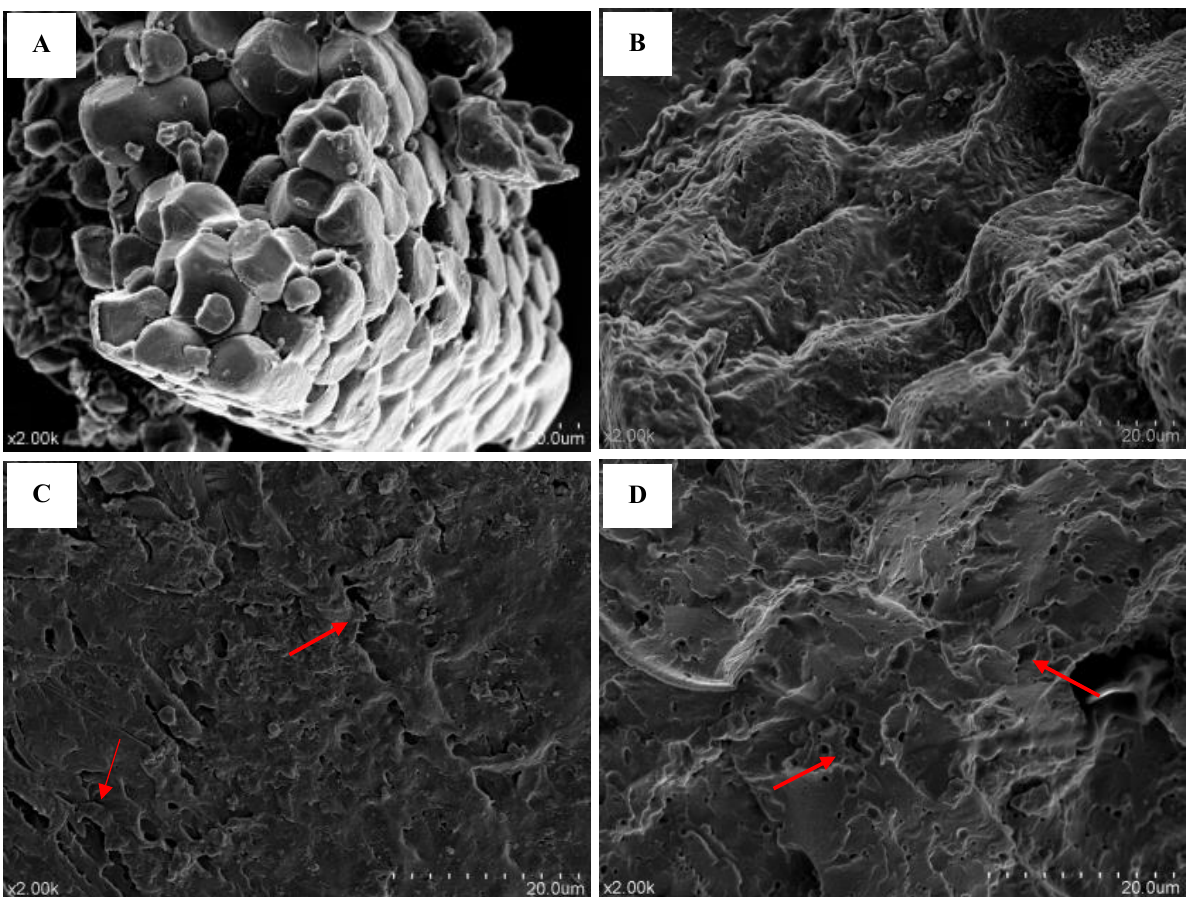
Figure 1. Scanning electron microscopy of whole Tartary buckwheat flour ( A ), fresh Tartary buck- wheat noodles ( B ), dried Tartary buckwheat noodles ( C ), and frozen Tartary buckwheat noodles ( D ).